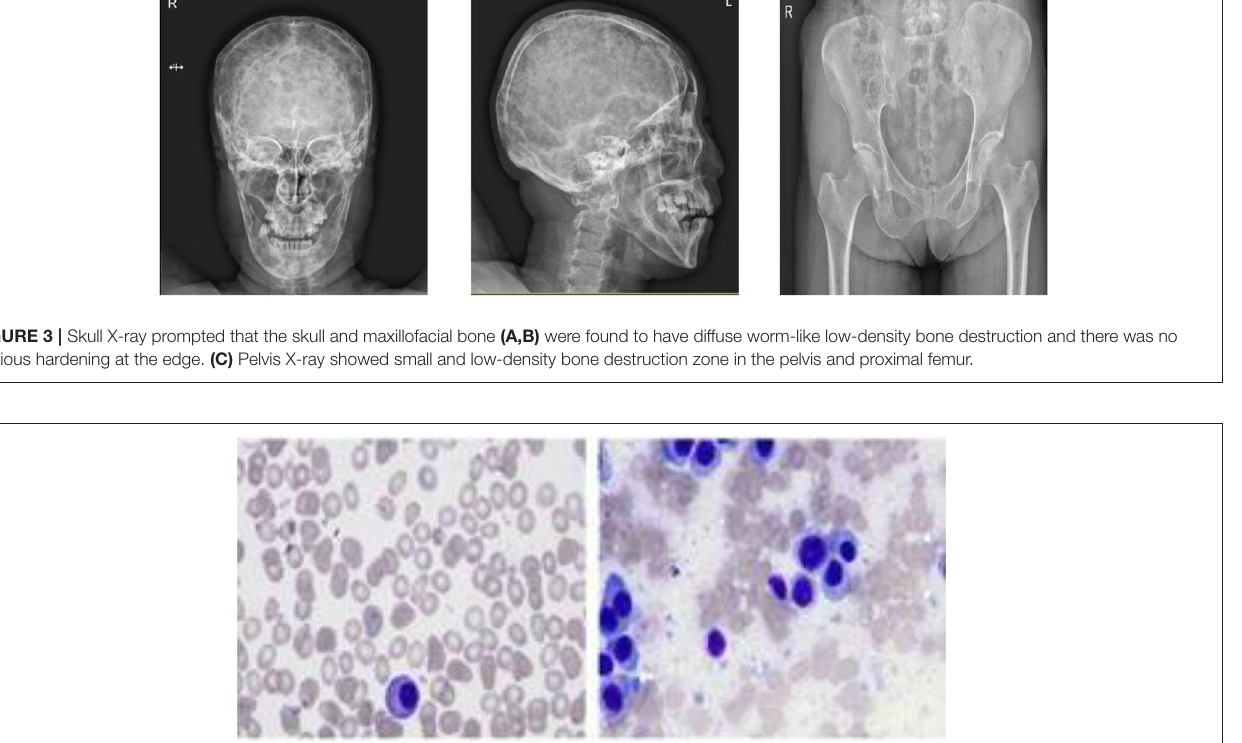
FIGURE 4 | Bone marrow considered multiple myeloma, suggesting a significant increase in the proportion of plasma cells and a small amount of naive plasma cells.